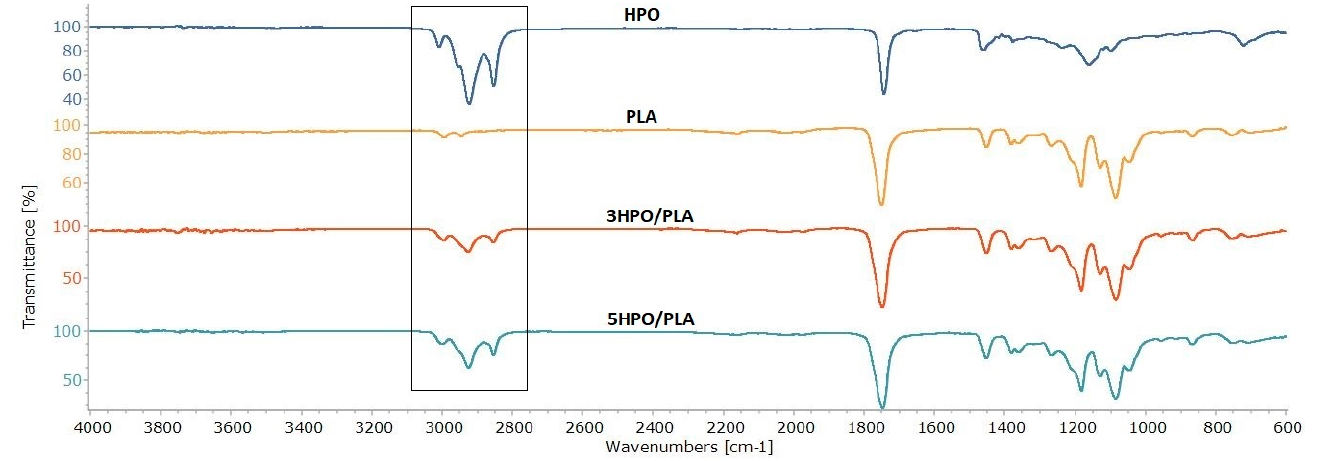
Figure 2. ATR-FTIR spectra of the HPO, the PLA, and the HPO/PLA electrospun nonwoven fabrics. The characteristic peaks of the HPO observed at 3308 − 1 , 2853 − 1 , 1743 cm − 1 , and 844 cm − 1 were assigned to aromatic C-H stretching, aliphatic C-H stretching, C=O stretching,